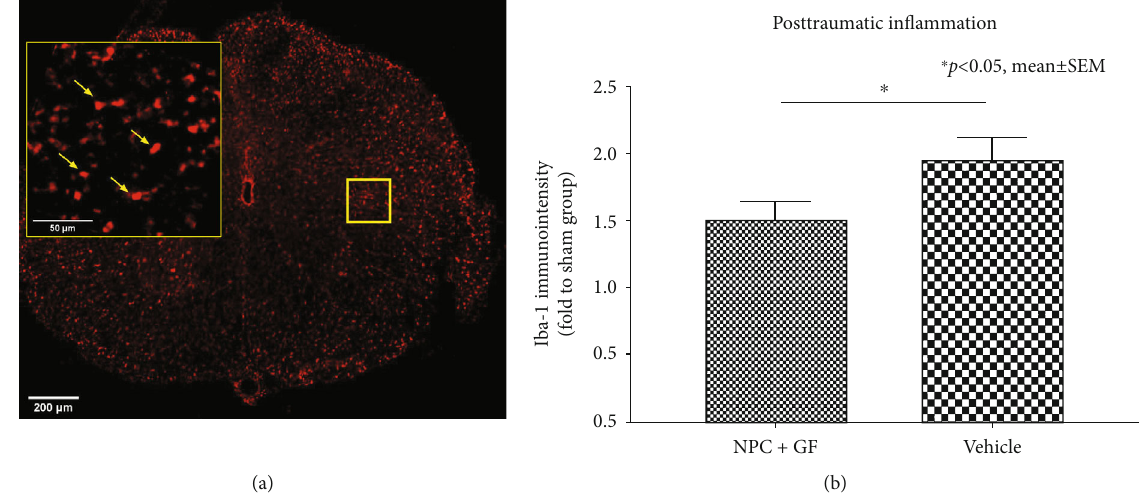
Figure 9: In vivo posttraumatic in fl ammation 8 weeks after cervical SCI. (a) Spinal cord cross-section stained for Iba1 (red), a marker for microglia/macrophages (10x magni fi cation). Inlay (yellow) with arrows (yellow) depicting the cell morphology (40x magni fi cation). (b) Quanti fi cation of Iba-1-immunointensity as a surrogate marker for posttraumatic in fl ammation, expressed in proportion to (fold to) the sham